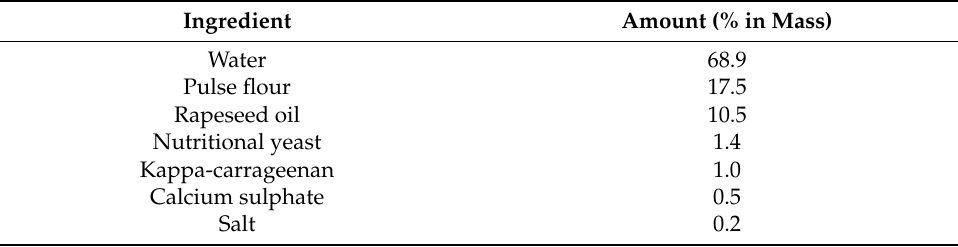
Table 1. The recipe for the preparation of pulse-based cheese analogues using different types of pulse